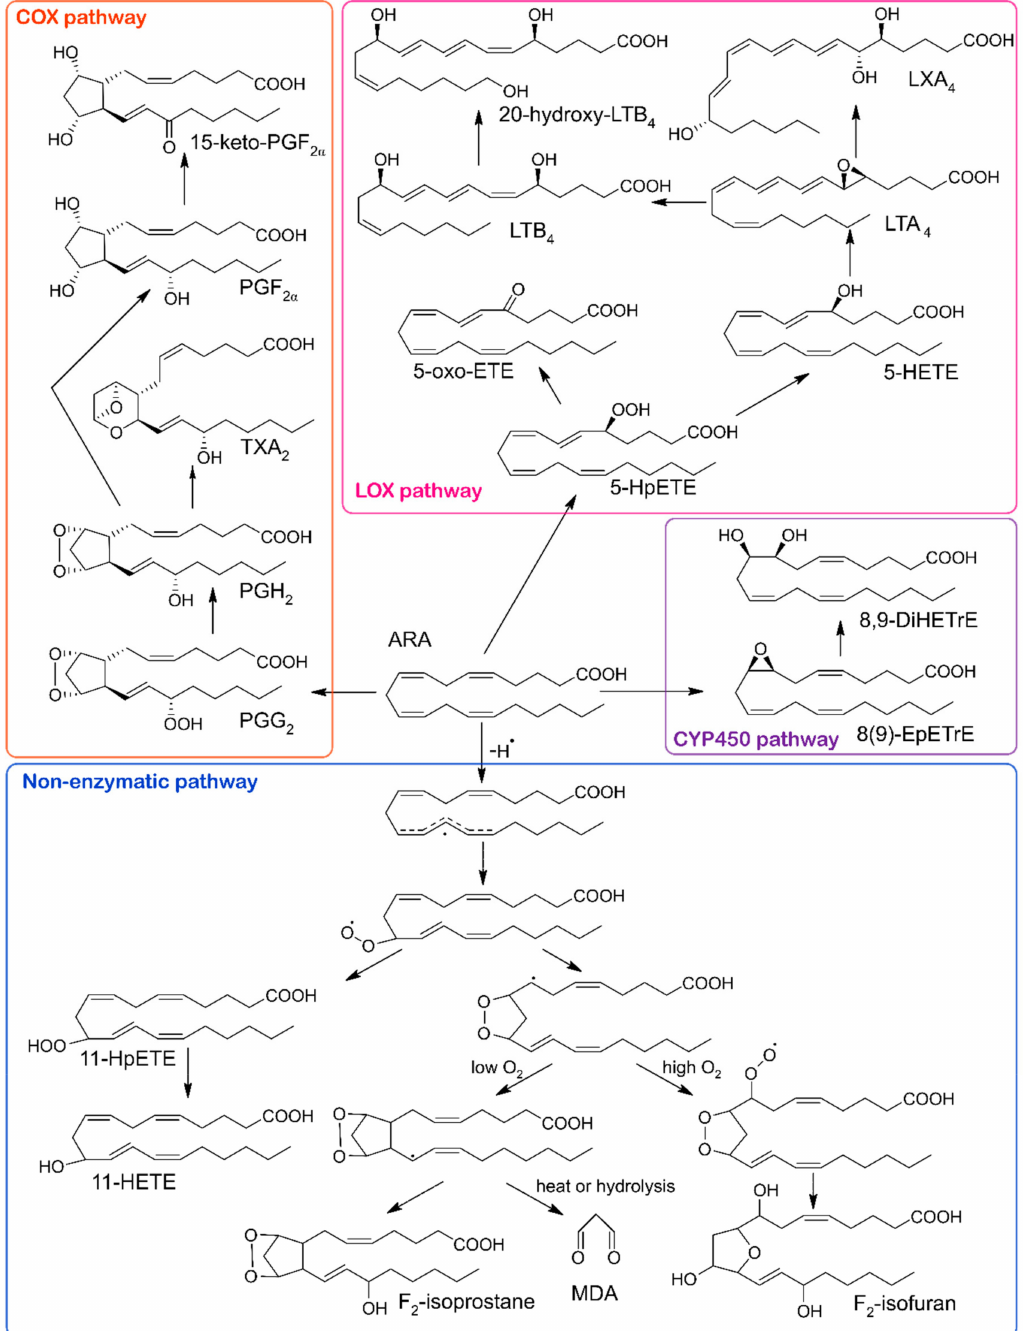
Figure 1. Conversion of ARA into oxylipins by COX, LOX, CYP 450 pathways and by the non-enzymatic pathway. COX, cyclooxygenase; LOX, lipoxygenase; CYP450, cytochrome P450; ARA, arachidonic acid; 5-HpETE, 5-hydroperoxyeicosatetraenoic acid; 5-oxo-ETE, 5-oxo-eicosatetraenoic acid; LTB 4 , leukotriene B4; 20-hydroxy-LTB 4 , 20-hydroxy-leukotriene B4; 5-HETE, 5-hydroxyeicosatetraenoic